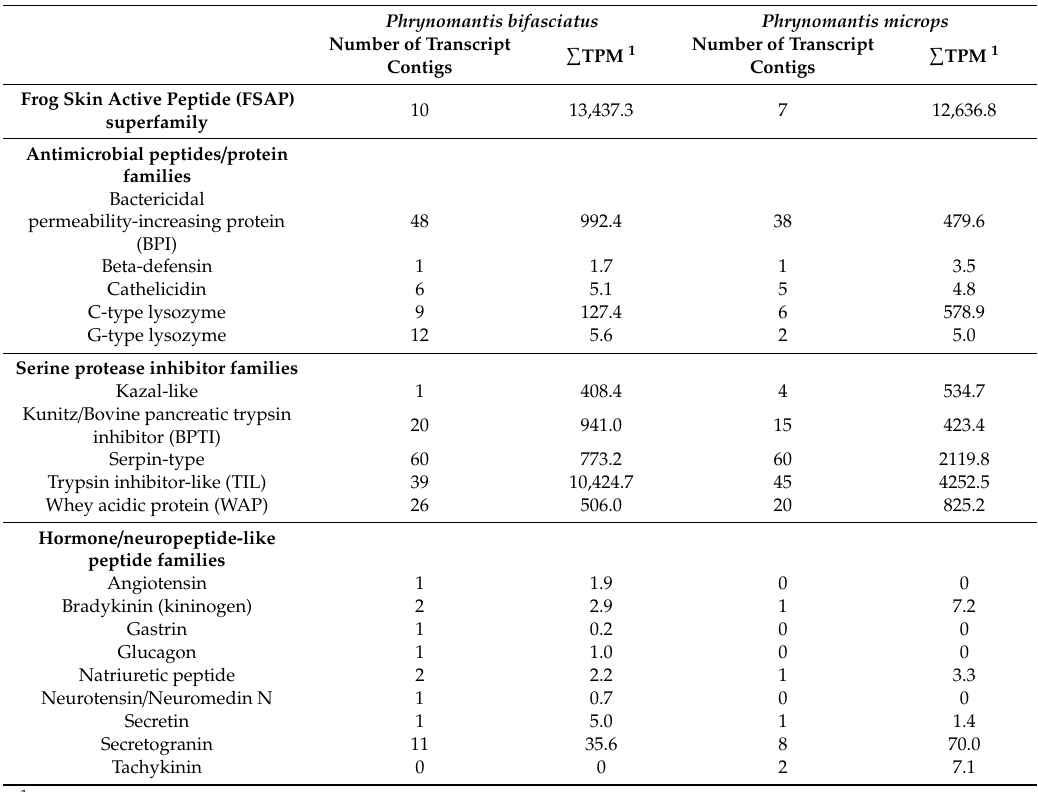
Table 1. Protein families encoded by recovered transcripts in both Phrynomantis species, including estimated transcript diversity (number of assembled transcript contigs) and estimated total expression level (sum of transcripts per million (TPM) of contigs representing the same gene / protein family).